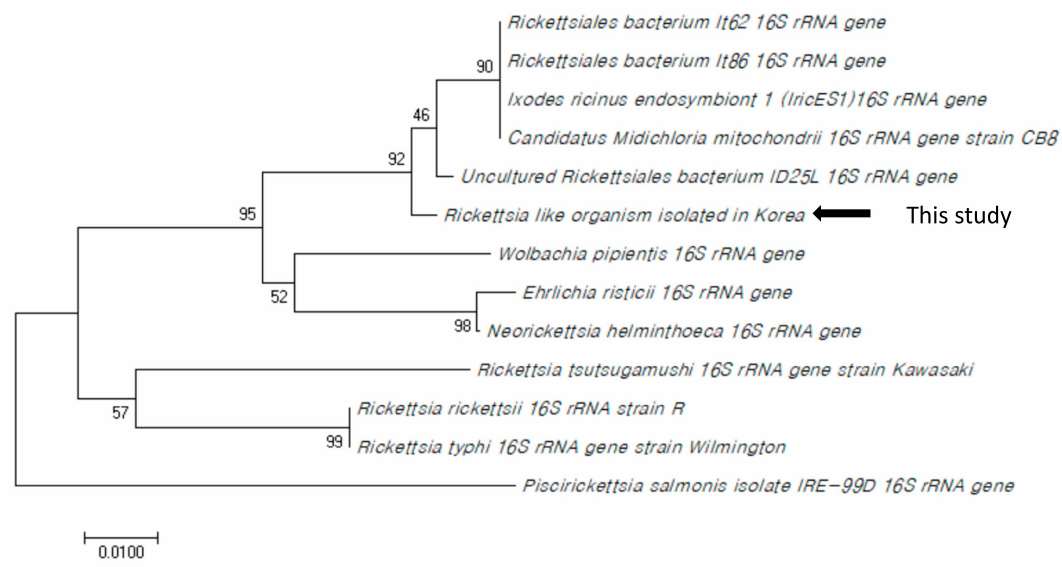
Figure 2. Phylogenetic analysis using partial sequence of the Rickettsia -like organism (RLO) 16S rRNA gene(188bp). Thetree wasconstructedusingthe neighbor-joiningmethodonMEGA7.0withabootstrap of 1000 generations (GenBank accession number: HG793392.1, AF037211.1, AJ880275.1,